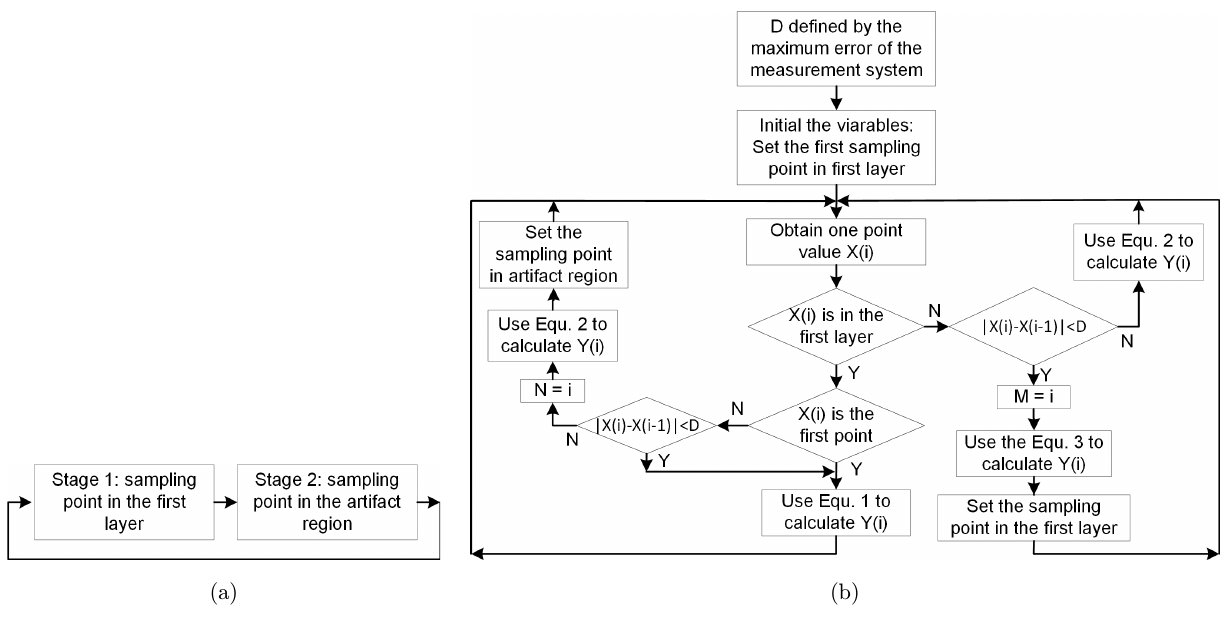
Fig. 4. Calculation steps of the proposed algorithm. (a) The whole process is divided into two-stage process model (b) block diagram of